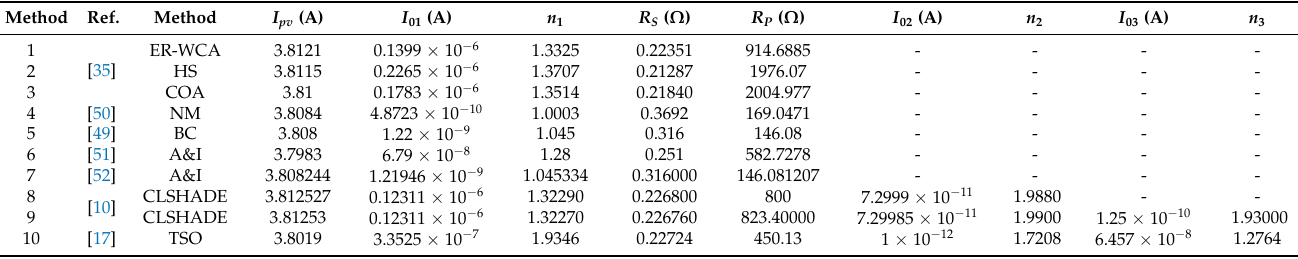
Table A2. Parameters of the Solarex MSX 60 module obtained using the literature methods presented in Table